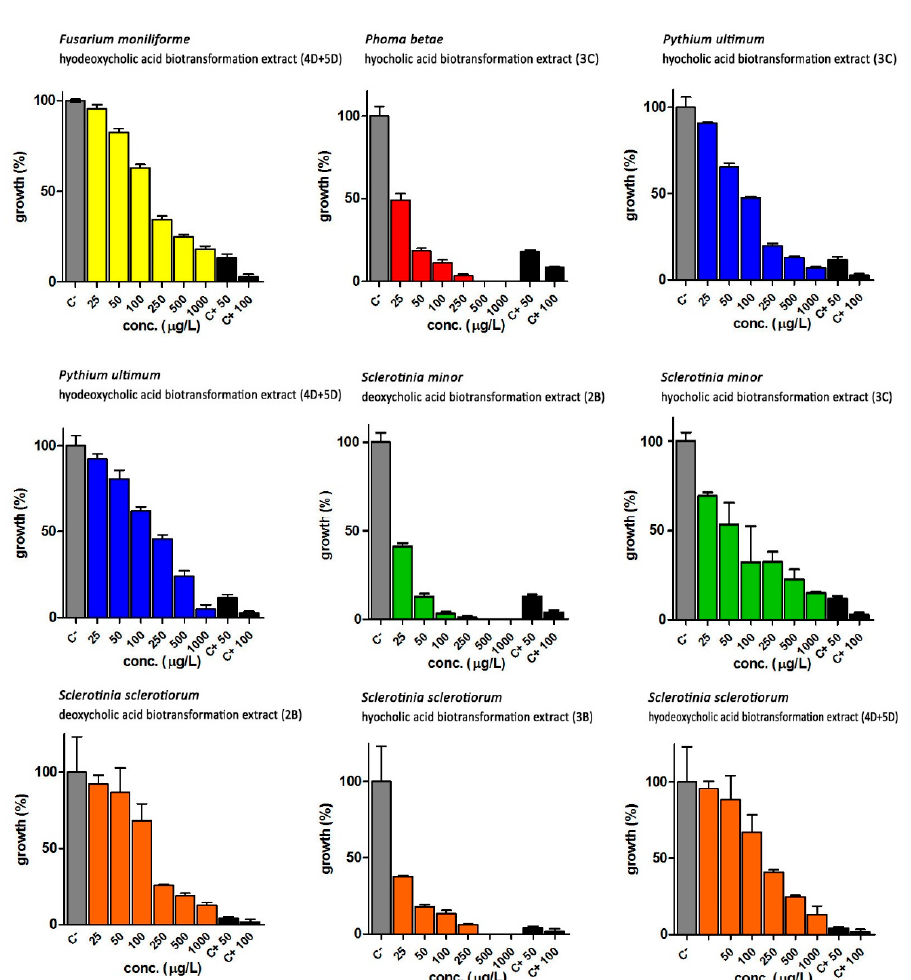
Figure 4. Growth inhibition of phytopathogenic fungi with secosteroids ( 2a , b , 3c and 4d + 5d ). FM = Fusarium moniliforme ; PB = Phoma betae ; PU = Pythium ultimum ; SM = Sclerotinia minor ; SS = Sclerotinia sclerotiorum . C − = DMSO; C+ 50 = fluconazole 50 µ g/mL; C+ 100 = fluconazole 100 µ g/mL. 2a = secosteroid from cholic acid, 2b = secosteroid from deoxycholic acid, 3c = secosteroid from hyocholic acid, 4d + 5d = secosteroids from hyodeoxycholic acid.